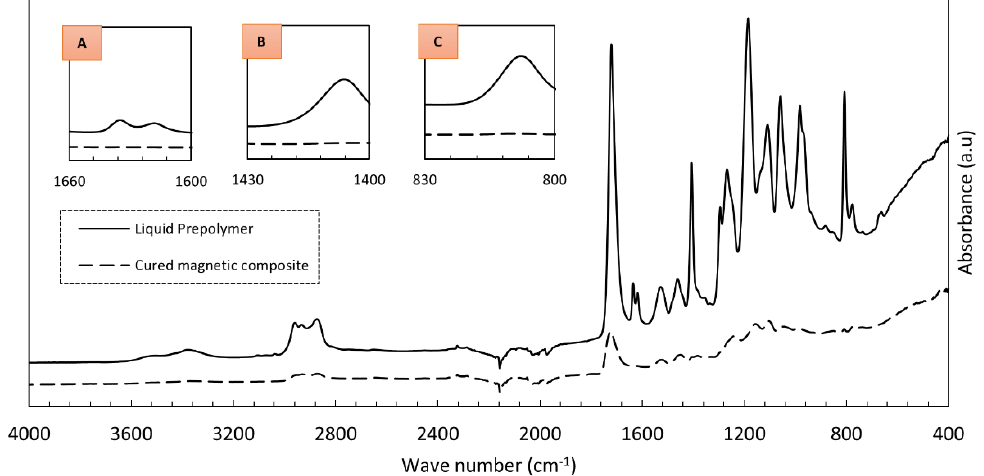
Figure 12. FTIR spectra of uncured liquid prepolymer and cured magnetic composite. Insets indicate FTIR spectral regions: ( A ) 1600 cm −1 to 1660 cm −1 , ( B ) 1400 cm −1 to 1430 cm −1 , and ( C ) 800 cm −1 to 830 FTIR spectral regions: ( A ) 1600 cm − 1 to 1660 cm − 1 , ( B ) 1400 cm − 1 to 1430 cm − 1 , and ( C ) 800 cm − 1 to cm −1 . 830 cm − 1